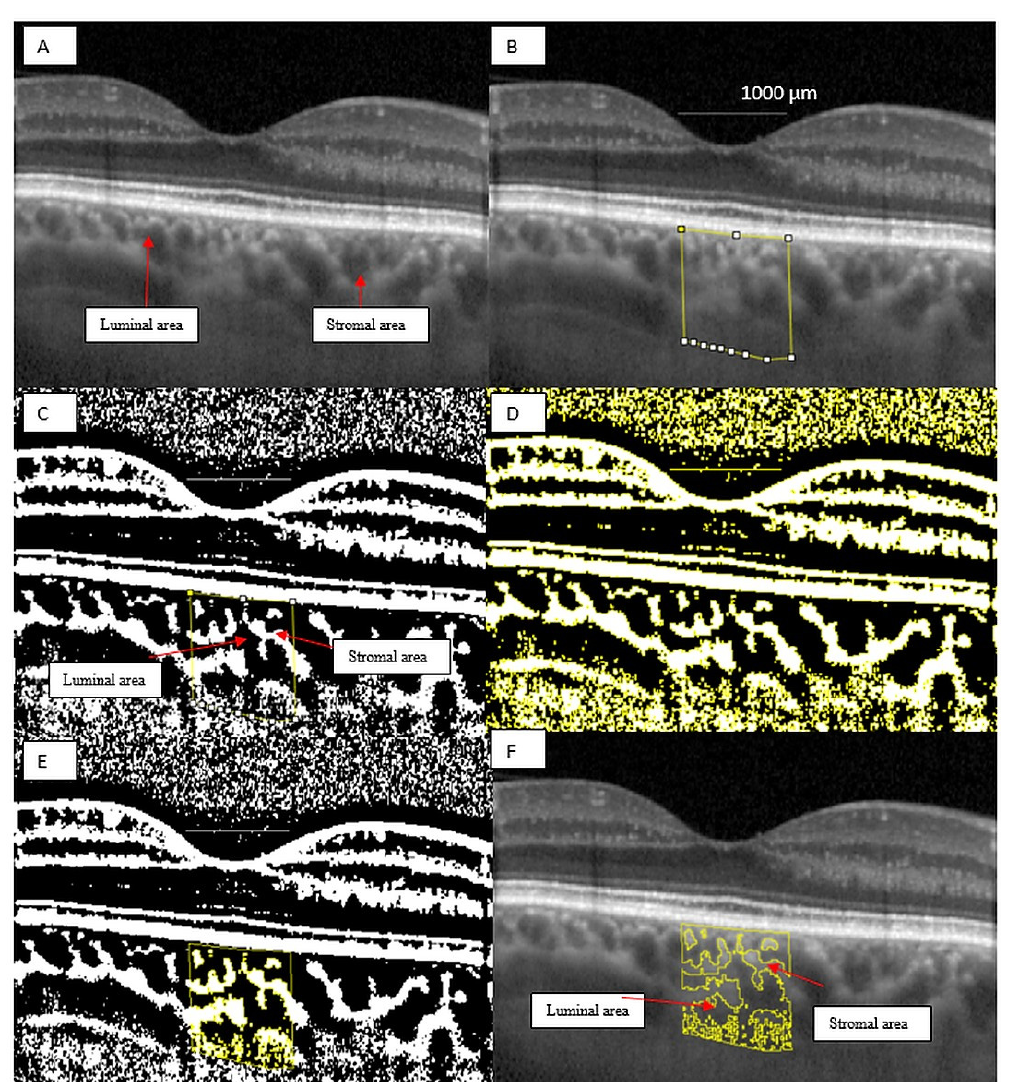
Figure 3. Image binarization for the choroid with normal choroidal thickness. ( A ) Original choroidal enhanced depth imaging (EDI) Spectral Domain-OCT (SD-OCT) 1 × 1 pixel* scan showing black area (luminal area, LA) and white area (stromal area, SA). ( B ) A 1 mm segment block of the subfoveal choroidal area. ( C ) The image was converted to 8-bit and Niblack auto local threshold tool was applied. ( D ) Color threshold was applied to highlight the luminal Area. ( E ) Composite image representing luminal area. ( F ) Overlay of region of interest created after image binarization was performed on the EDI-OCT image. * We used stretched 1 × 1 pixel images for illustrative purposes only, to help visualize the details of the retinal and choroidal structures.